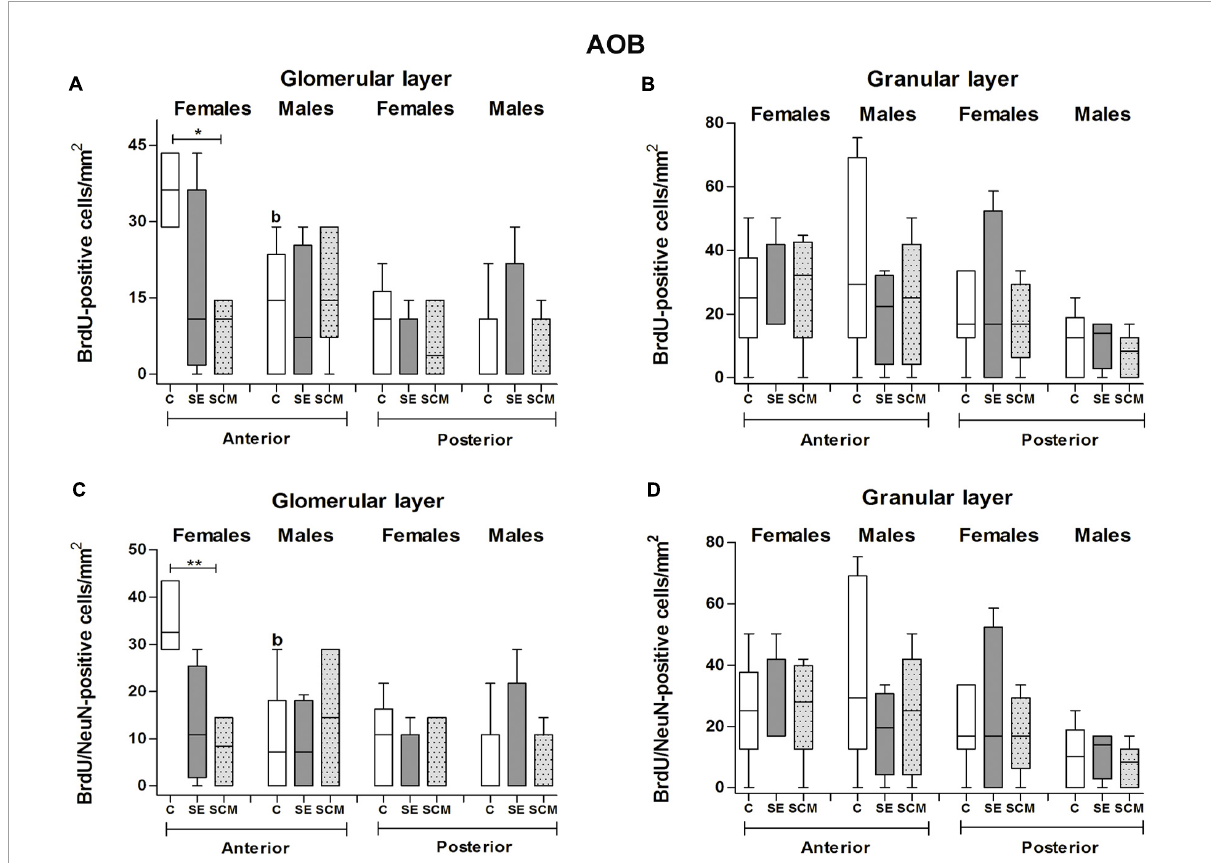
FIGURE6 Data analysis of the number of BrdU and BrdU/NeuN-positive cells in the glomerular and granular cell layers of the accessory olfactory bulb (AOB) in control (C), social exposure to a conspecific (SE), and social cohabitation with mating (SCM) groups Kruskal-Wallis followed by Dunn’s post-hoc tests; * p < 0.05 and ** p < 0.01 were considered significant. Differences between females and males were analyzed using the Mann-Whitney U test where a p < 0.05, and b p < 0.01. Female subjects; C = 6, SE = 4, SCM = 6. Male subjects; C = 6, SE = 4, SCM = 5. a mean different from the opposite sex p < 0.05. b mean different from the opposite sex p < 0.01.